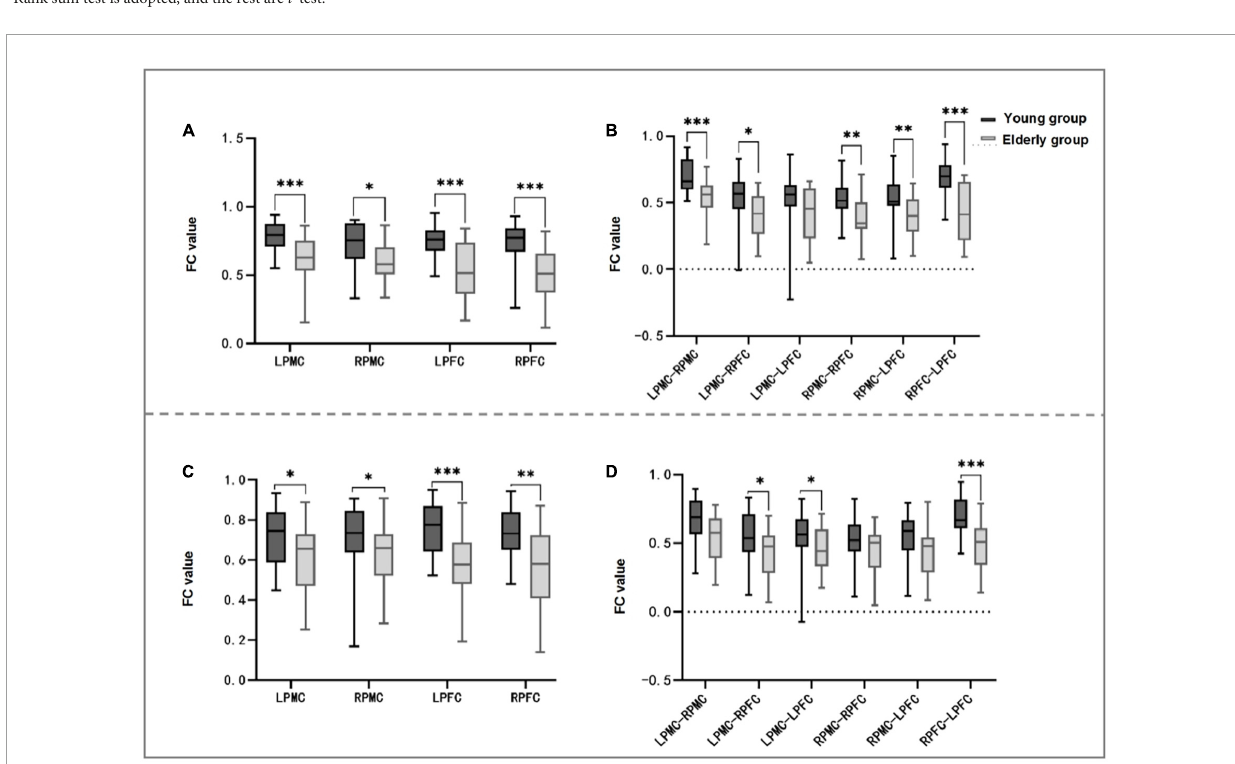
FIGURE4 Comparison between groups of FC of homologous and heterologous ROI in forward and reverse judgment test. (A,B) Shows the forward judgment test, panel (A) is the inter-group comparison of FC values of homologous ROI between young and elderly, and panel (B) is the inter-group comparison of heterologous ROI. (C,D) Shows the comparison between groups of homologous ROI and heterologous ROI in the reverse judgment test. It can be seen from panels (A,C) that the FC values of homologous ROI between the two groups are statistically different in the forward and reverse judgment tests ( P < 0.05). Panel (B) shows that the FC values of LPMC-RPMC, LPMC-RPFC, RPMC-RPFC, RPMC-LPFC, and RPFC-LPFC in the elderly group are significantly lower than those in the young group ( P < 0.05). It can be seen from panel (D) that the FC values of LPMC-RPFC, LPMC-LPFC and RPFC-LPFC in the elderly group are significantly lower than those in the young group ( P < 0.05). FC, functional connectivity; LPFC, left prefrontal cortex; RPFC, right prefrontal cortex; LPMC, left primary motor cortex; RPMC, right primary motor cortex; ROI, region of interest; ∗ P < 0.05; ∗∗ P < 0.01; ∗∗∗ P <